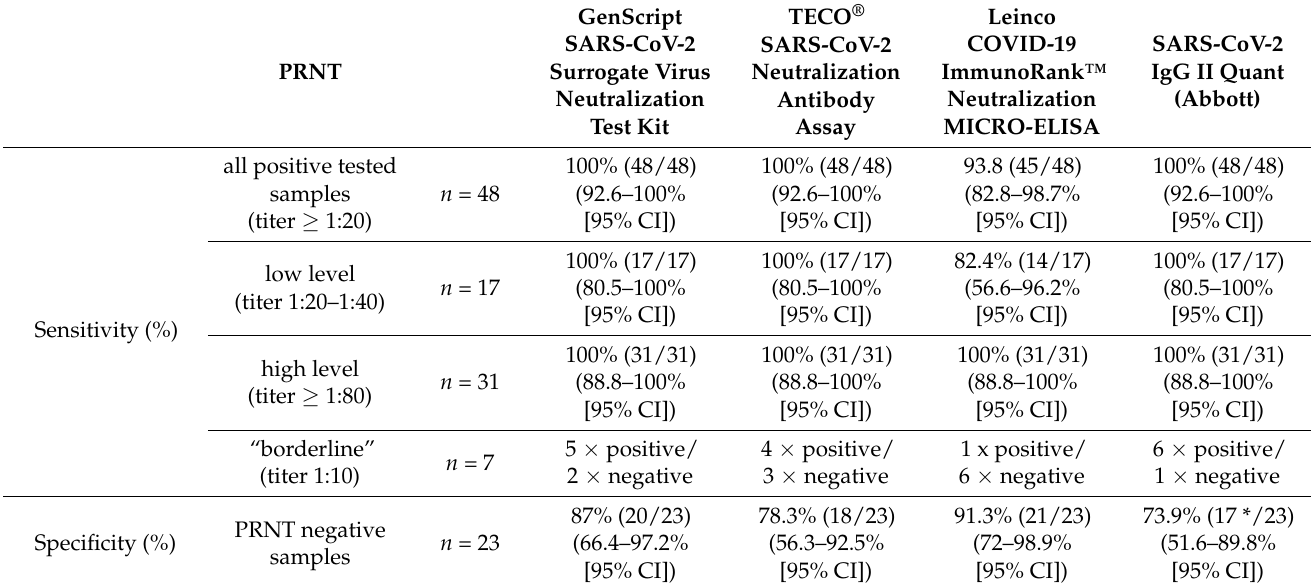
Table 1. Overall sensitivity and specificity of the examined SARS-CoV-2 antibody assays in comparison to the